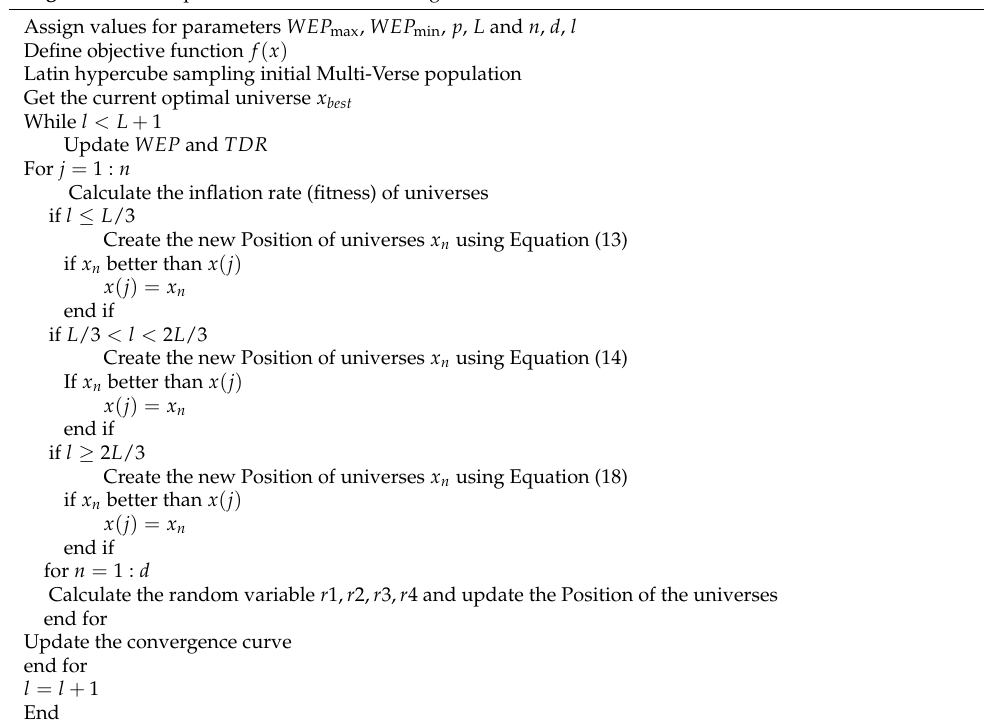
Algorithm 1. The pseudocode for MDMVO